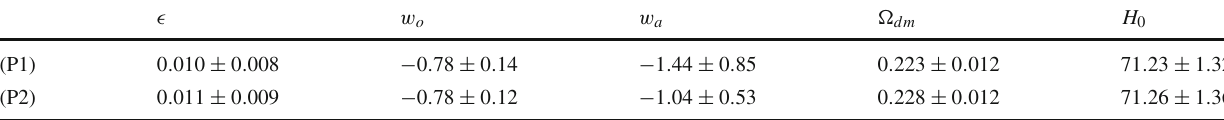
Table 1 Constraints on the cosmological parameters for P1 and P2 considering the Gaussian prior H 0 = 73 . 52 ± 1 . 62 km s − 1 Mpc −